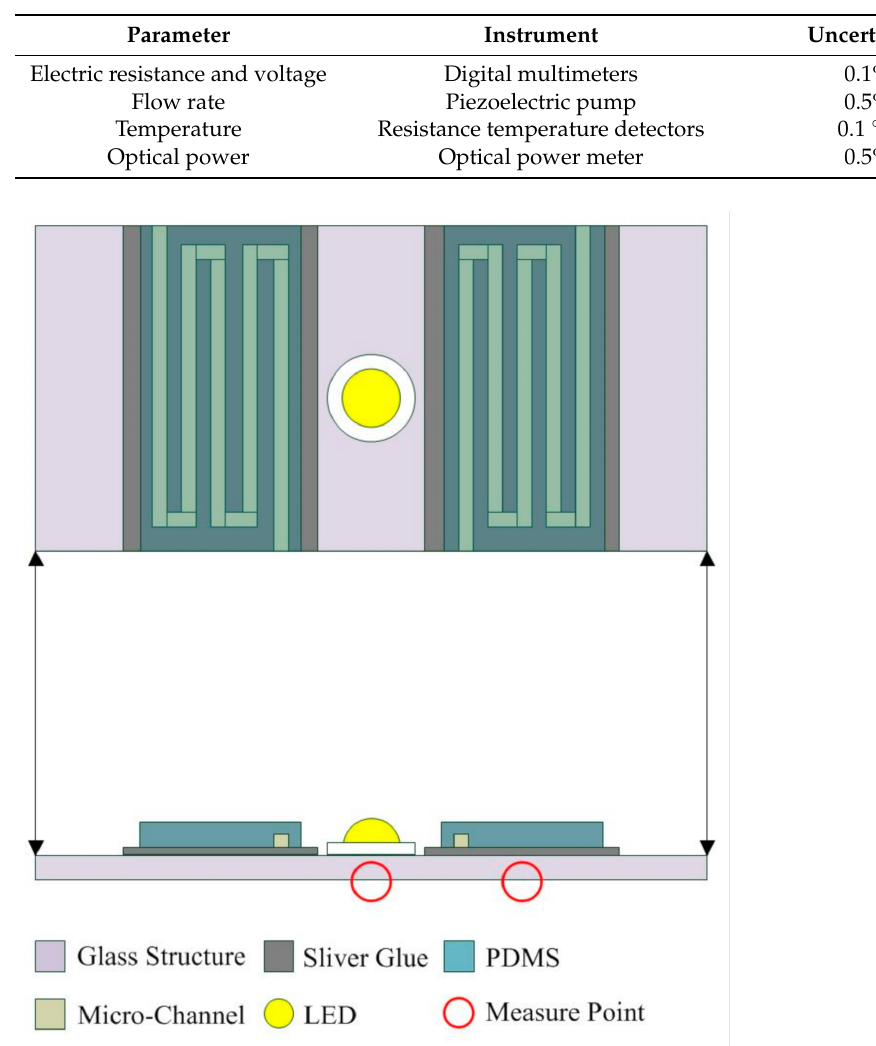
Table 1. Uncertainty analysis of various parameters.